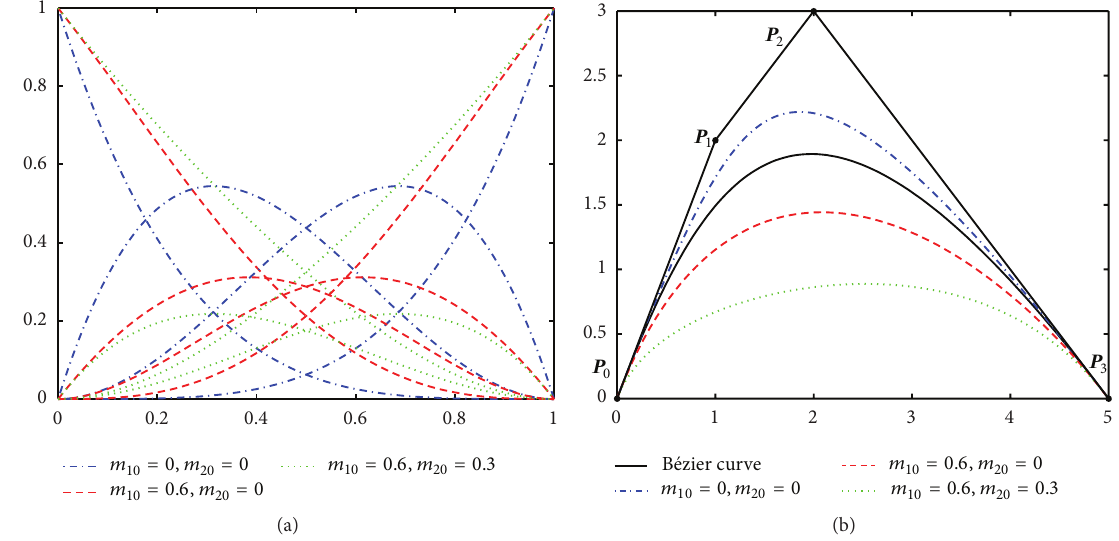
Figure 4: Quasi-Bernstein basis functions and Quasi-B´ezier curves when 𝑛 1 = 3 and 𝑛 2 = 4 .